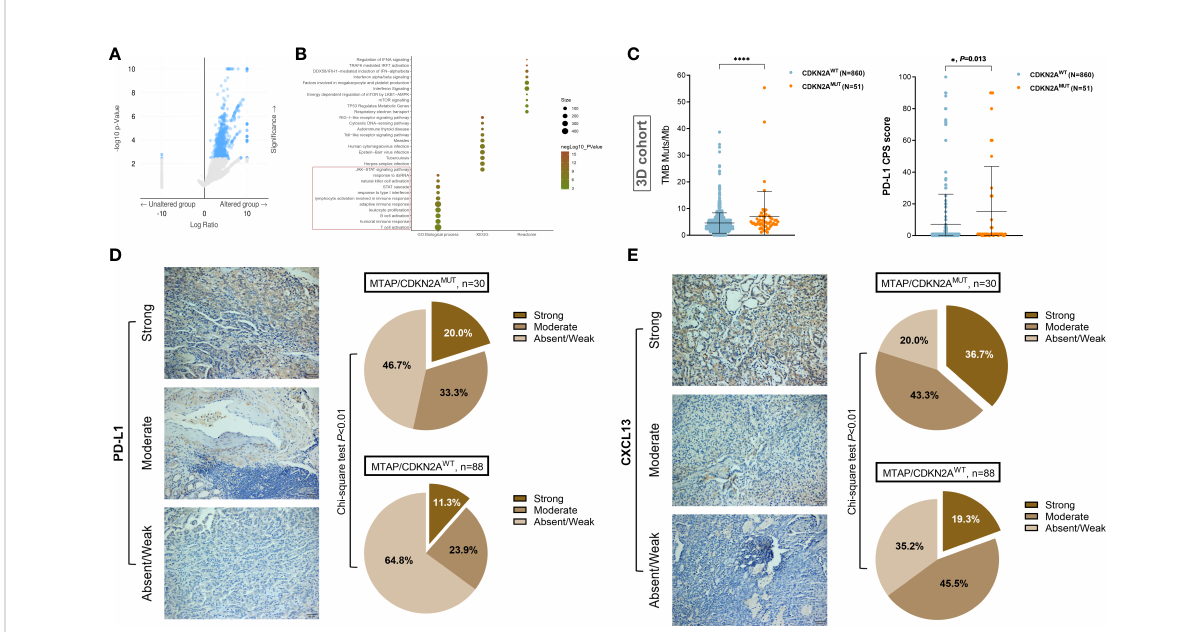
FIGURE 5 MTAP / CDKN2A MUT predicts tumor heterogeneity and TME characterizations of RCC patients from the 3D and FUSCC cohorts. (A) Identi fi cation of differential altered genes between MTAP / CDKN2A MUT and unaltered groups in the Western cohort using the “ limma ” R package with a threshold of Log 10 ( q -value) >2. (B) Gene Ontology (GO), Kyoto Encyclopedia of Genes and Genomes (KEGG), and Reactome functional enrichment analyses were performed to speculate on the biological functions and tumor environment changes involved in MTAP/CDKN2A MUT . (C) Tumor mutation burden (TMB) and PD-L1 levels in the CDKN2A MUT group compared with the CDKN2A WT group in 1,170 Chinese patients with RCC from the 3D medicine cohort. (D, E) Protein expression levels of immune checkpoint molecule, PD-L1, and the key lymphokine that recruits tertiary lymphoid structures, CXCL13, were evaluated in ccRCC samples with available genomic data from the discovery set of the FUSCC cohort. The relative expression of PD-L1 and CXCL13 was de fi ned as strong, moderate, and absent/weak staining according to